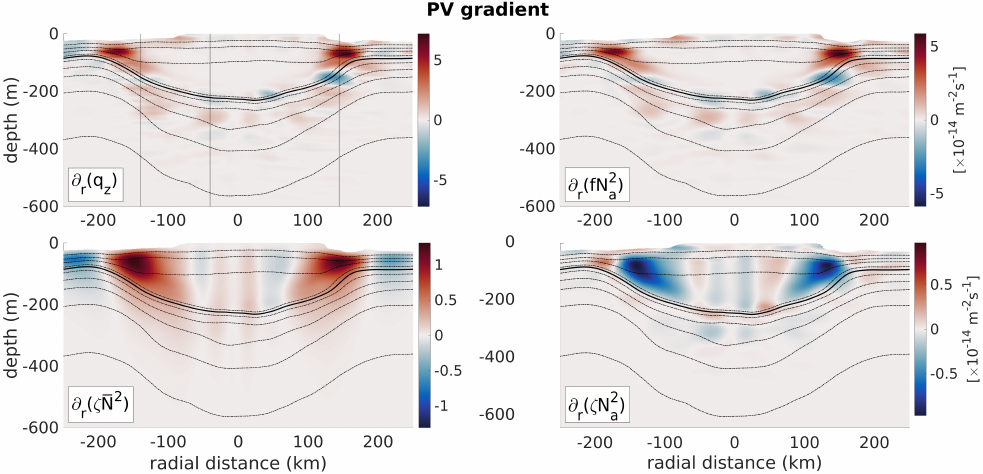
Figure 15. Same as Figure 13 for the radial gradient of the vertical components of Ertel’s potential vorticity anomaly.